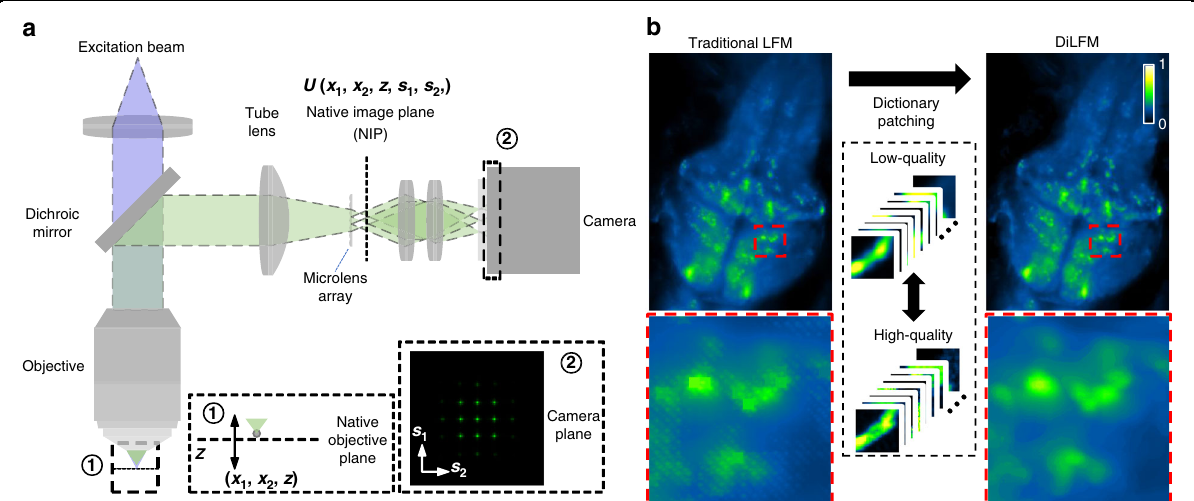
Fig. 1 Principle of DiLFM. a Light fi eld microscopy (LFM) imaging scheme. 3D distributed samples will be collected by standard microscopy (i.e., an objective with a tube lens), then coded by a microlens array (MLA) and captured by a camera. Zoom-in panel ① shows the relationship of a sample space point with the pattern in the native objective plane (NIP). Zoom-in panel ② shows an exemplary LFM PSF captured by the camera. b Principle of DiLFM. After ringing-reduced RL reconstruction, DiLFM replaces low-quality image elements with high-quality ones to suppress reconstruction